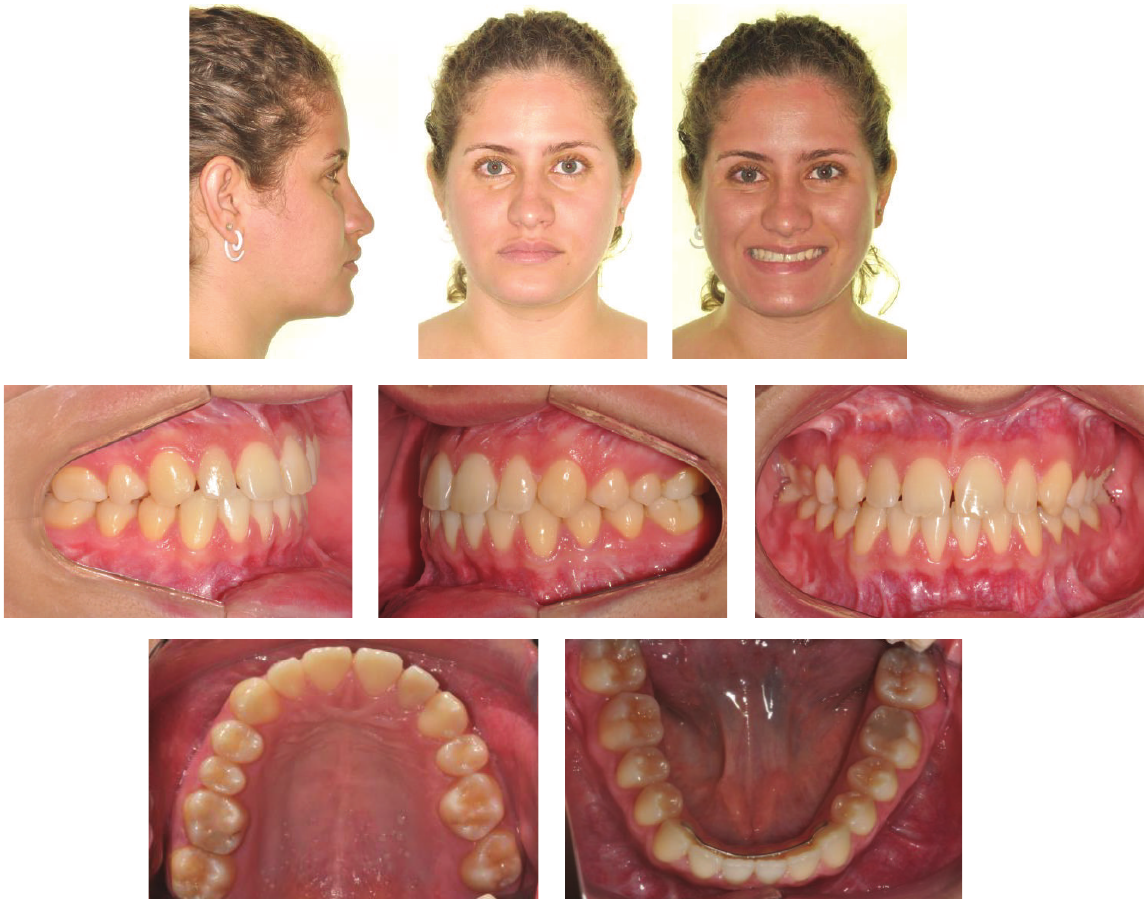
Figure 9: Posttreatment extraoral and intraoral photographs after 7 years.